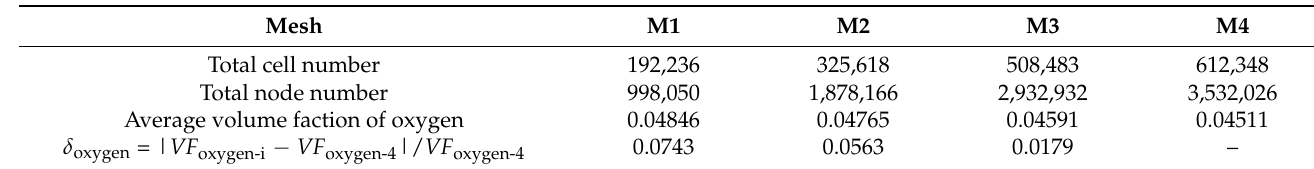
Table 2. Error statistics of different meshes.